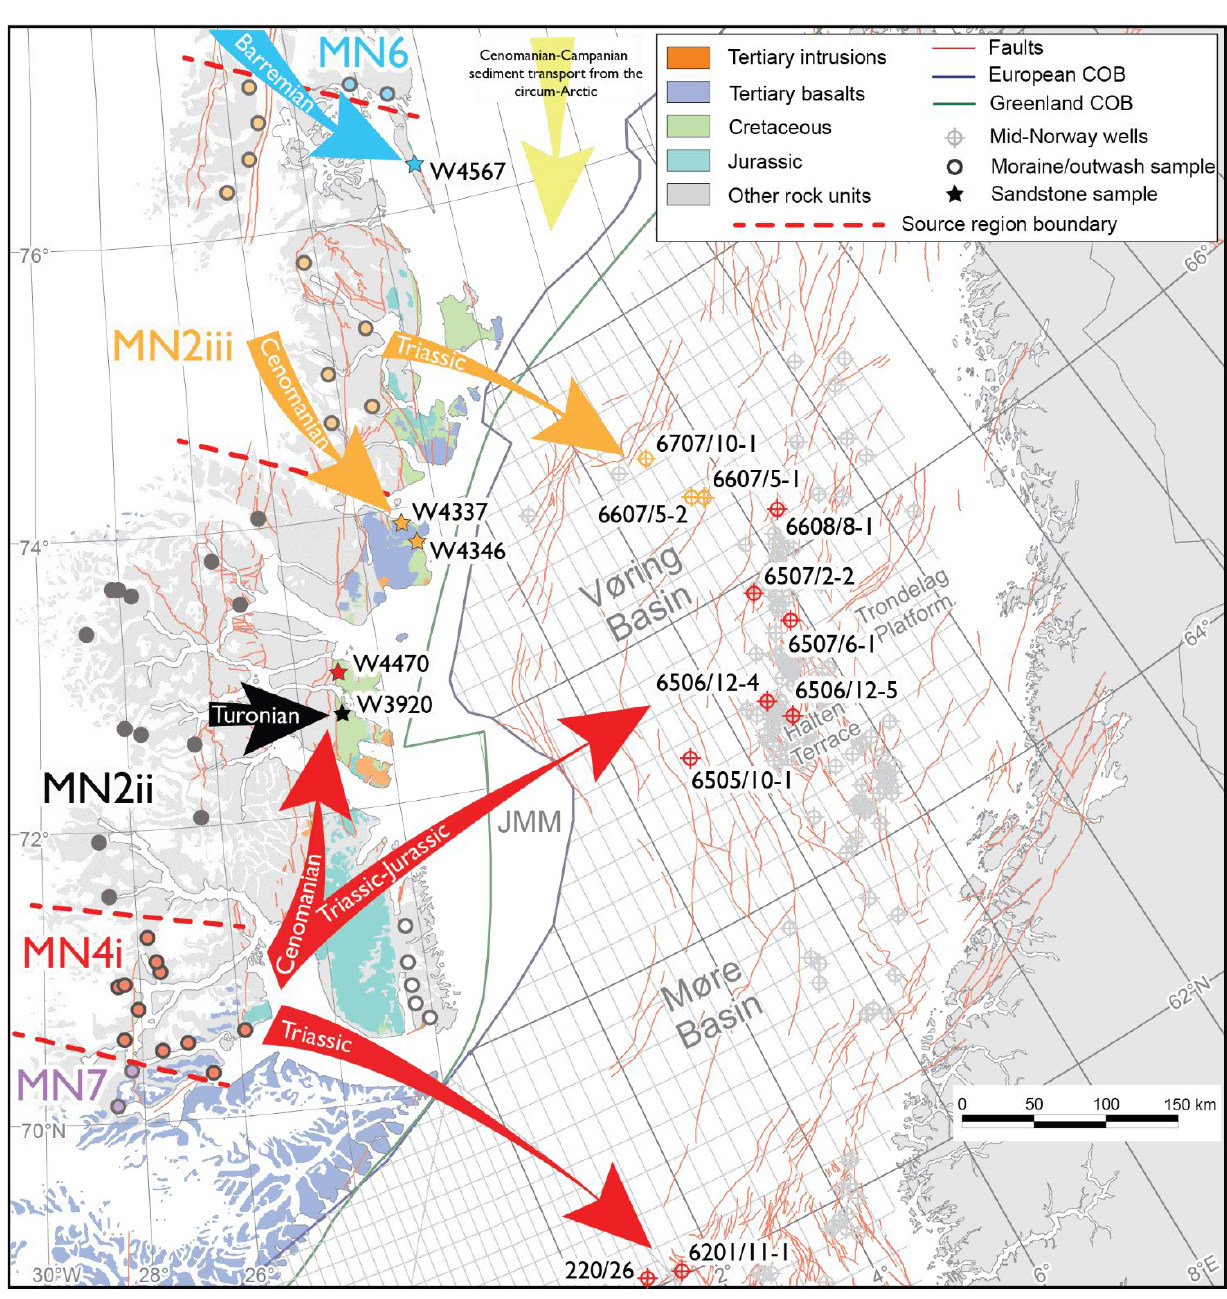
Figure 4. Map of the Greenland – Mid-Norway region prior to the onset of seafloor spreading in the Palaeogene, with present-day coordinates. The East Greenland crystalline basement and Caledonian orogenic belt are divided into five sediment source regions, as defined by moraine/outwash provenance signatures. Cretaceous sandstone samples [3] and offshore wells [1,3] are coloured according to the East Greenland source region. Provenance arrows indicate the approximate timing (note that the Cretaceous is divided into stages) and direction of source-to-sink transport, based on the published detrital data.